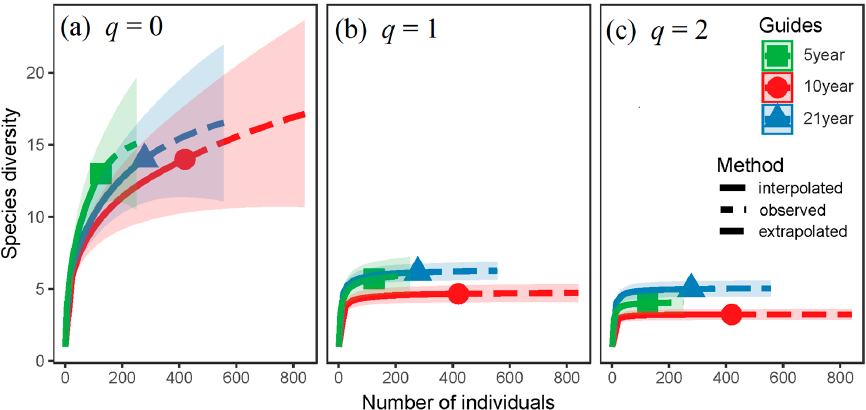
Figure 3. Sample size based rarefaction and extrapolation of soil arthropod diversity for Hill number ( a ) richness ( q = 0), ( b ) Shannon diversity ( q = 1), and ( c ) Simpson diversity ( q = 2) with 95% bootstrapped confidence intervals (shaded areas).